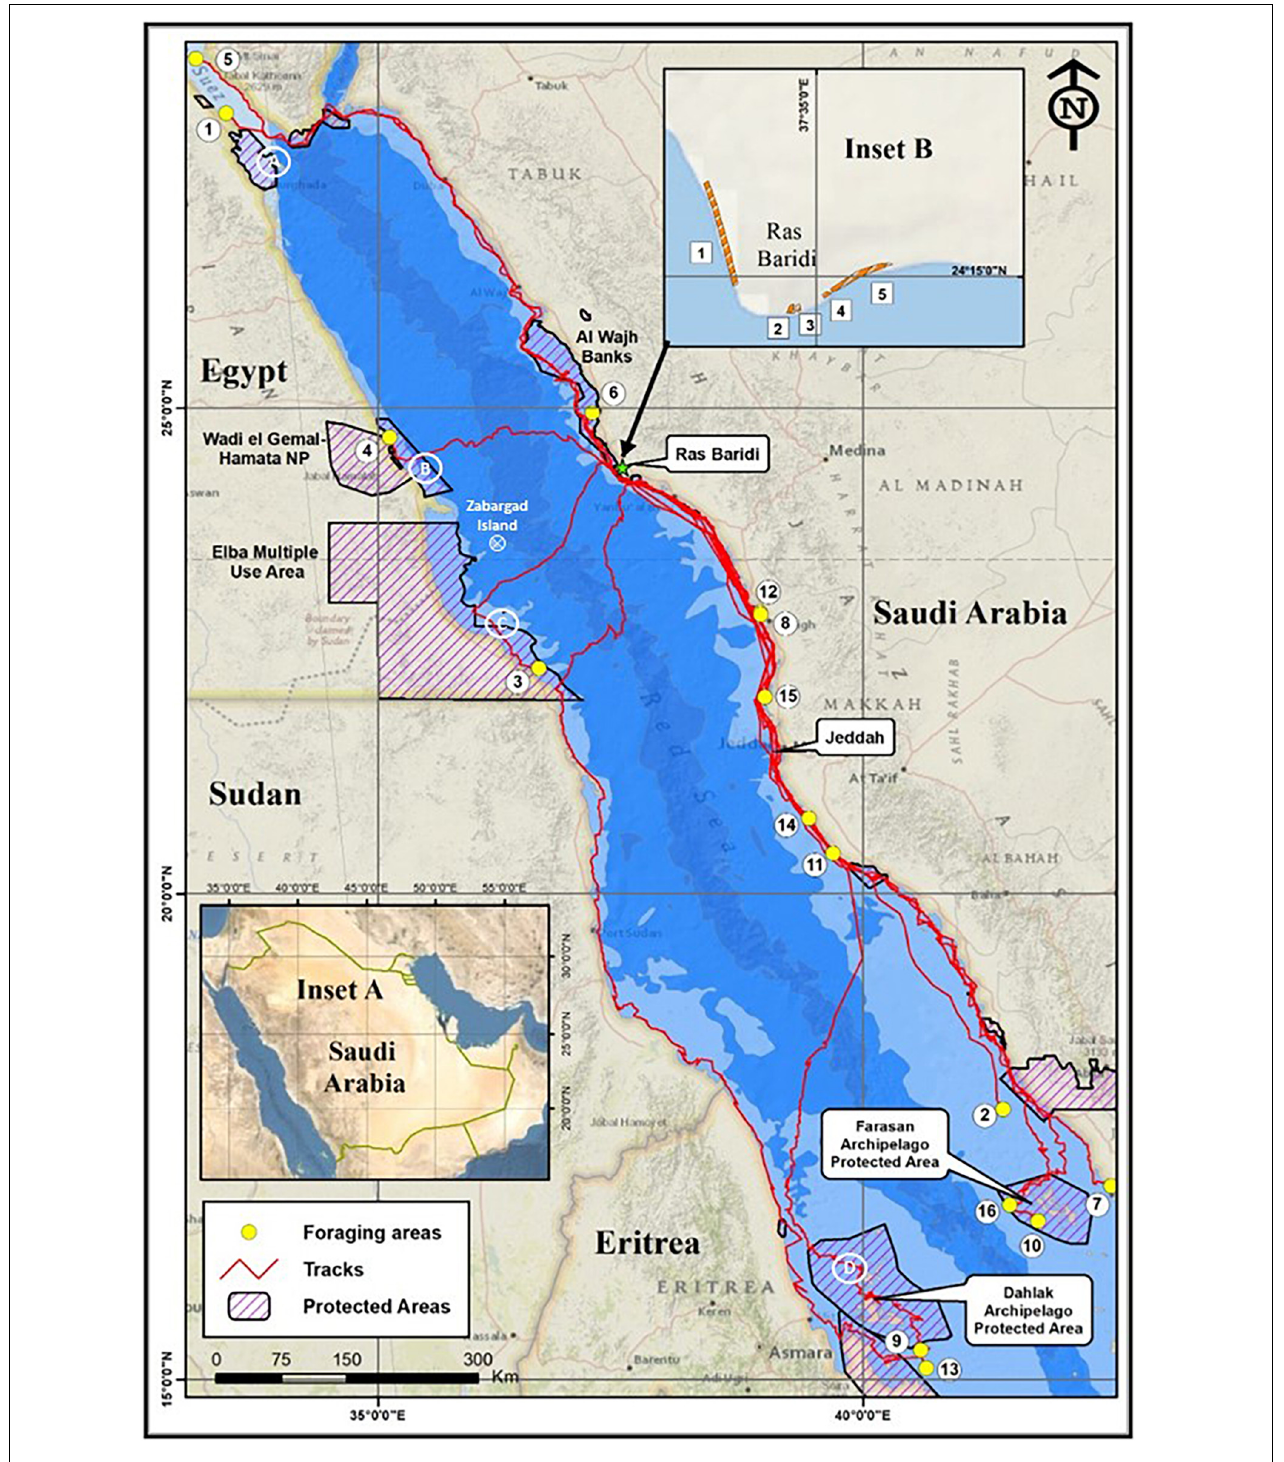
FIGURE 1 | Map of the Red Sea showing the distribution of foraging areas of 16 green turtles that nested at Ras Baridi on the eastern coast of Saudi Arabia. Inset A provides regional orientation. Inset B shows the distribution of beaches at Ras Baridi. Circled numbers = identification of forging areas used by 16 post-nesting green turtles in the present study. Green Star = Ras Baridi. White circled X = Zabargad Island; white circled letters = general location of foraging areas used by the green turtles tracked by Attum et al. (2014). Depth contours: light blue = coastal shelf < 200 m, medium blue = > 200 m, dark blue > 1000 m. Sources: National Geographic, Esri, DeLorme, HERE, UNEP-WCMC, USGS, NASA, ESA, METI, NRCAN, GEBCO, NOAA, iPC, and Esri, DigitalGlobe, GeoEye, i-cubed, USDA FSA, USGS, AEX, Getmapping, Aerogrid, IGN, IGP, swisstopo, and the GIS User Community by ESRI software